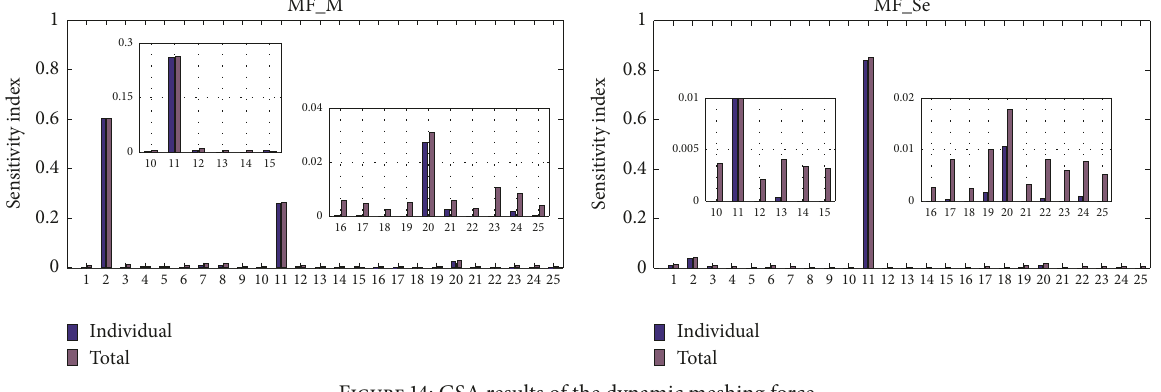
Figure 14: GSA results of the dynamic meshing force.